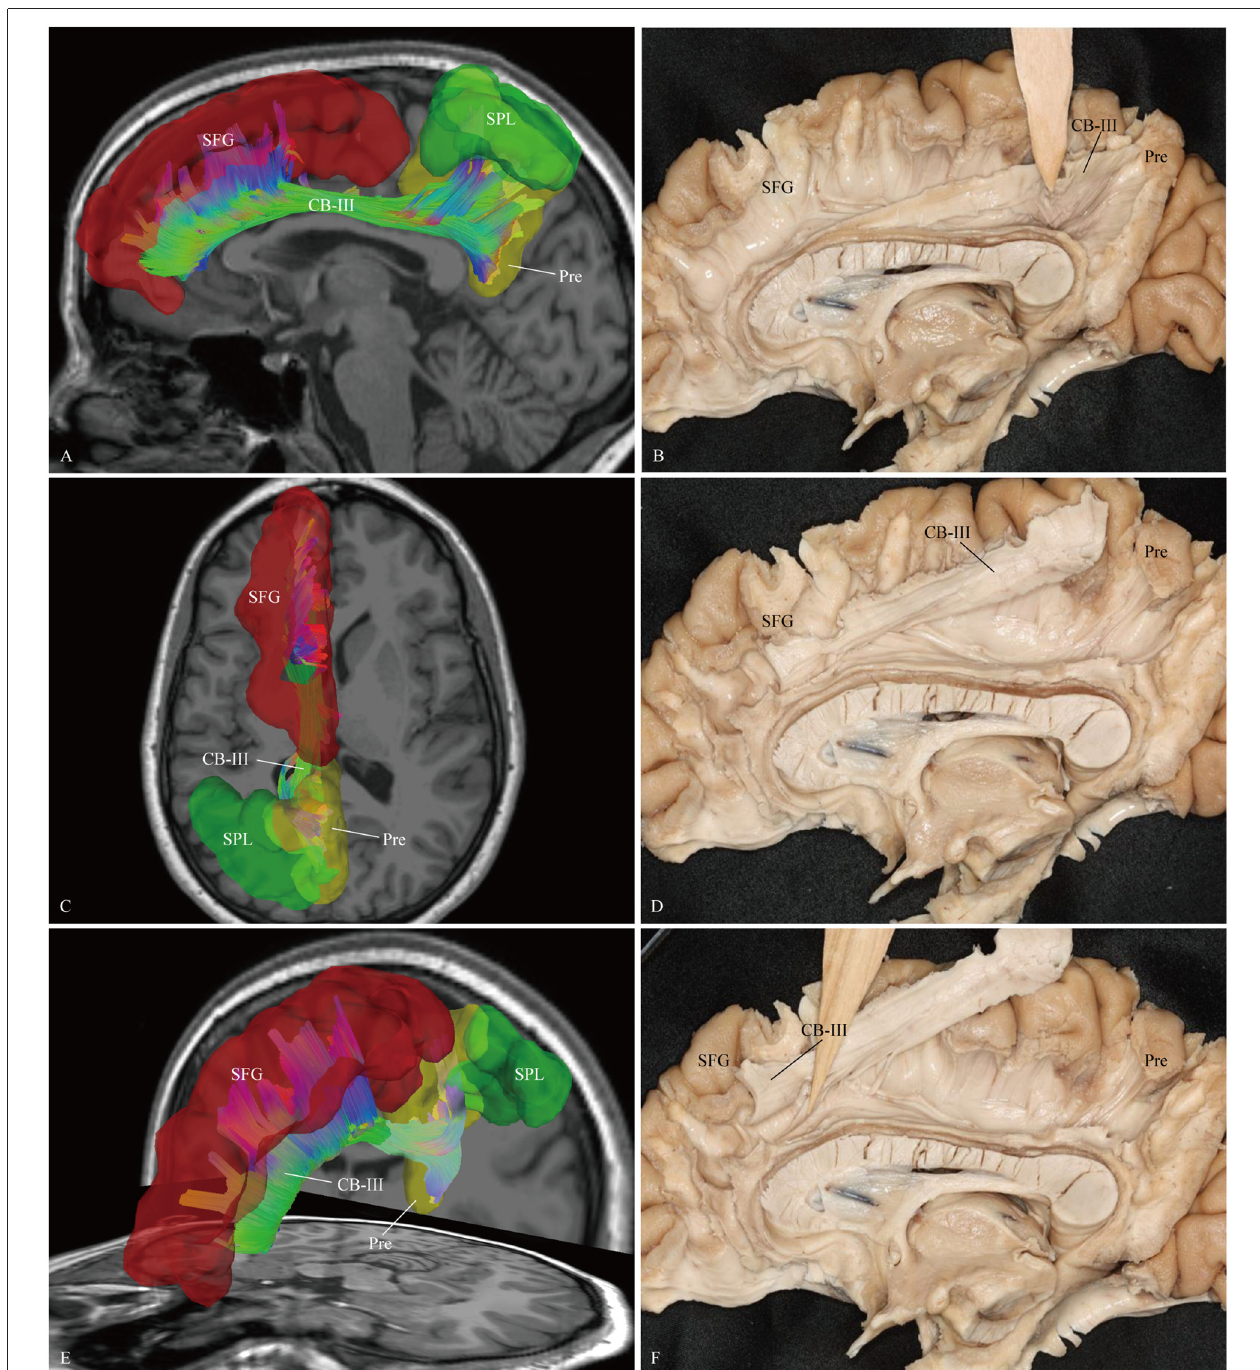
FIGURE 5 | In vivo fiber tractography and fiber dissection of the CB-III. (A–D) The CB-III originates from the superior parietal lobule (SPL) and precuneus, then extends along the trunk of the CC. (E,F) Finally, the fibers associate with the anterior and middle parts of the medial aspect of the SFG. SFG, superior frontal gyrus; SPL, superior parietal lobule; Pre,